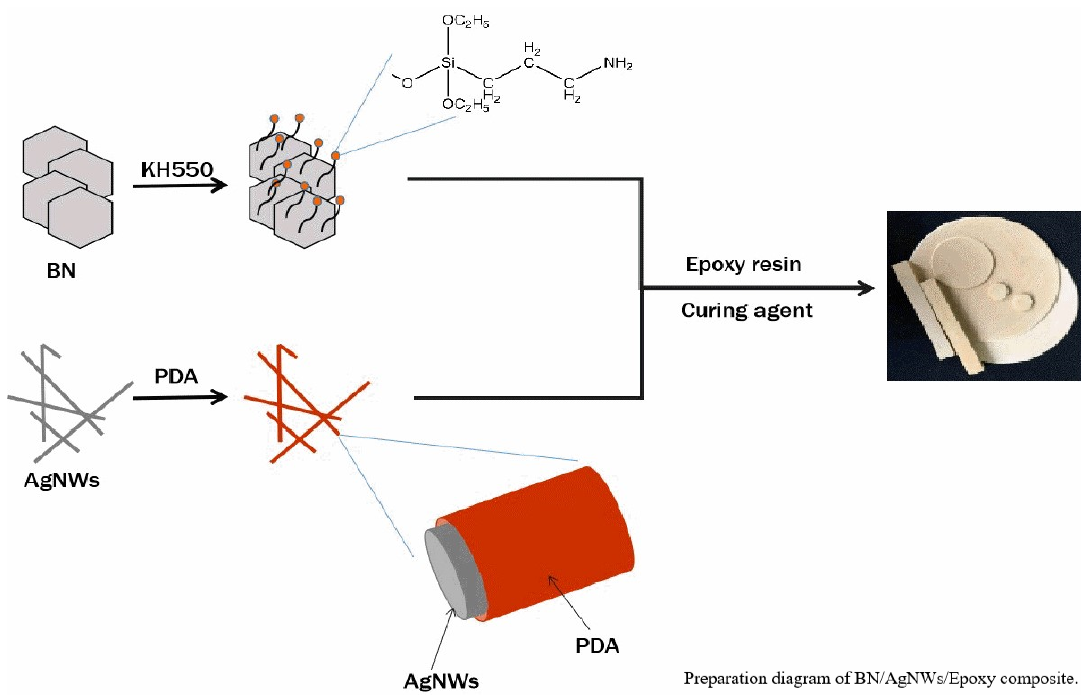
Figure 1. Preparation of BN/AgNWs/Epoxy composite.